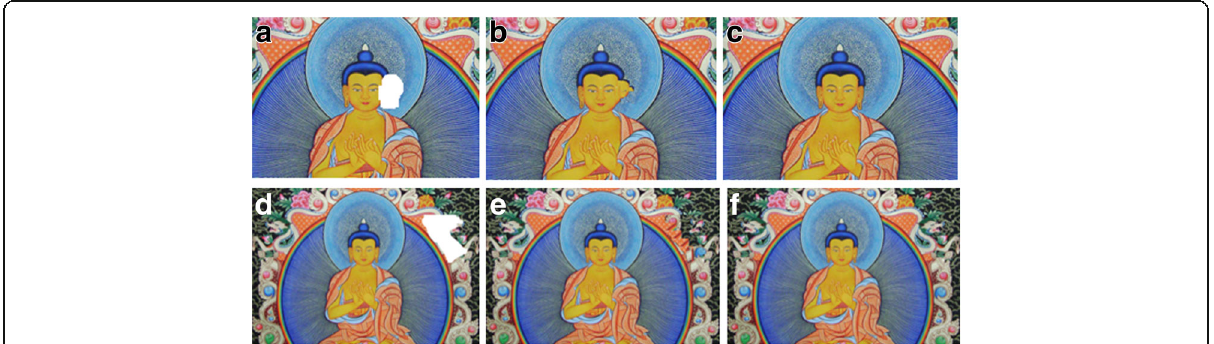
Fig. 15 Image restoration results using the different algorithms. a , d Original input image, missing region is marked in white. b , e Repaired result of exemplar-based image inpainting. c , f Repaired result of